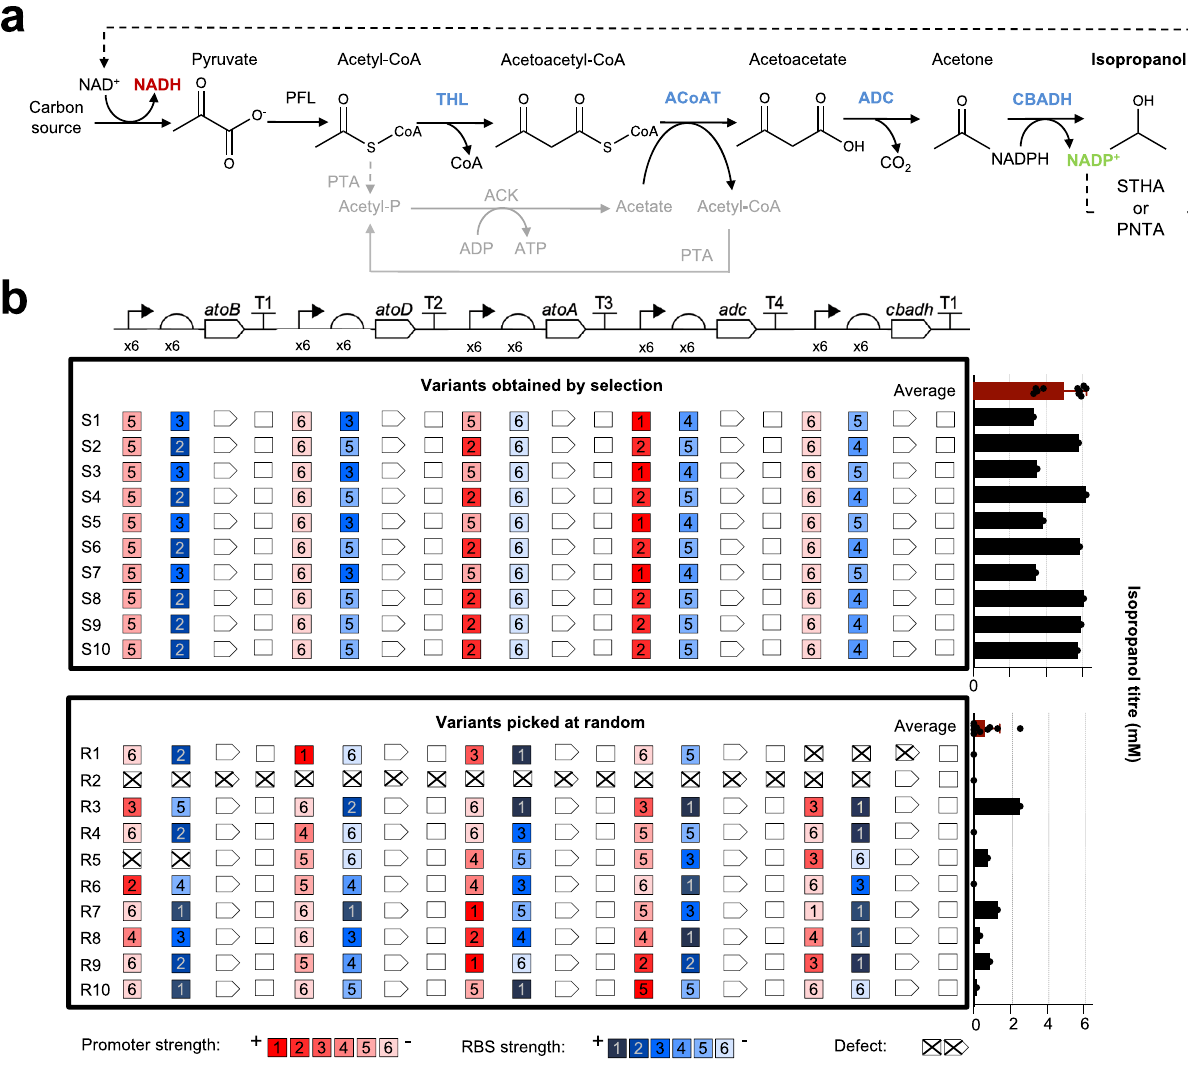
Fig. 6 Selection of an isopropanol production pathway with optimized regulatory elements. a A synthetic isopropanol production pathway for E. coli . Thiolase (acetyl-CoA acetyltransferase) THL (encoded by atoB ) catalyzes the condensation of two acetyl-CoA molecules to one acetoacetyl-CoA, releasing one free CoA molecule. Acetoacetyl-CoA transferase ACoAT (comprising two subunits encoded by atoA and atoD ) transfers the CoA group from acetoacetyl-CoA to acetate, yielding acetoacetate and acetyl-CoA. Acetoacetate is decarboxylated by acetoacetate decarboxylase ADC (encoded by adc ), resulting in acetone and CO2. Finally, acetone is reduced to isopropanol by CBADH. The acetate consumed by ACoAT can be regenerated from the resulting acetyl-CoA by phosphate acetyltransferase PTA and acetate kinase ACK. The NADP + generated during the reduction of acetone can be employed by transhydrogenases STHA and PNTA to regenerate the NAD + required to sustain anaerobic growth. b A library of isopropanol pathway- encoding plasmids was combinatorially assembled using mixtures of promoters and RBSs, expected to cause a diversity of performance in terms of fl ux, accumulation of intermediates, and expression-associated metabolic burden. 10 ‘ S ’ pathway variants were isolated by redox selection in E. coli AL cells and 10 ‘ R ’ pathway variants were isolated at random. Sequencing was used to determine the parts present in each case, which are shown aligned below the corresponding part in the design. Only two different permutations of parts were identi fi ed among the S variants, whereas all 10R variants were unique. Two R variants were defective, lacking one or more expected parts, whereas all S variants were complete. For comparison of isopropanol production, AL cells containing the S and R variants were cultured in M9 glucose medium for 17 h, then individual and average isopropanol titers in culture broths of both groups were determined. For both variants obtained by selection and variants picked at random, n = 10 biologically independent samples. In each set, black bars represent individual biological replicates, and the red bar represents the mean value with standard deviation indicated by the error bar obtained from the corresponding set of individual biological replicates. Source data are provided as a Source Data fi